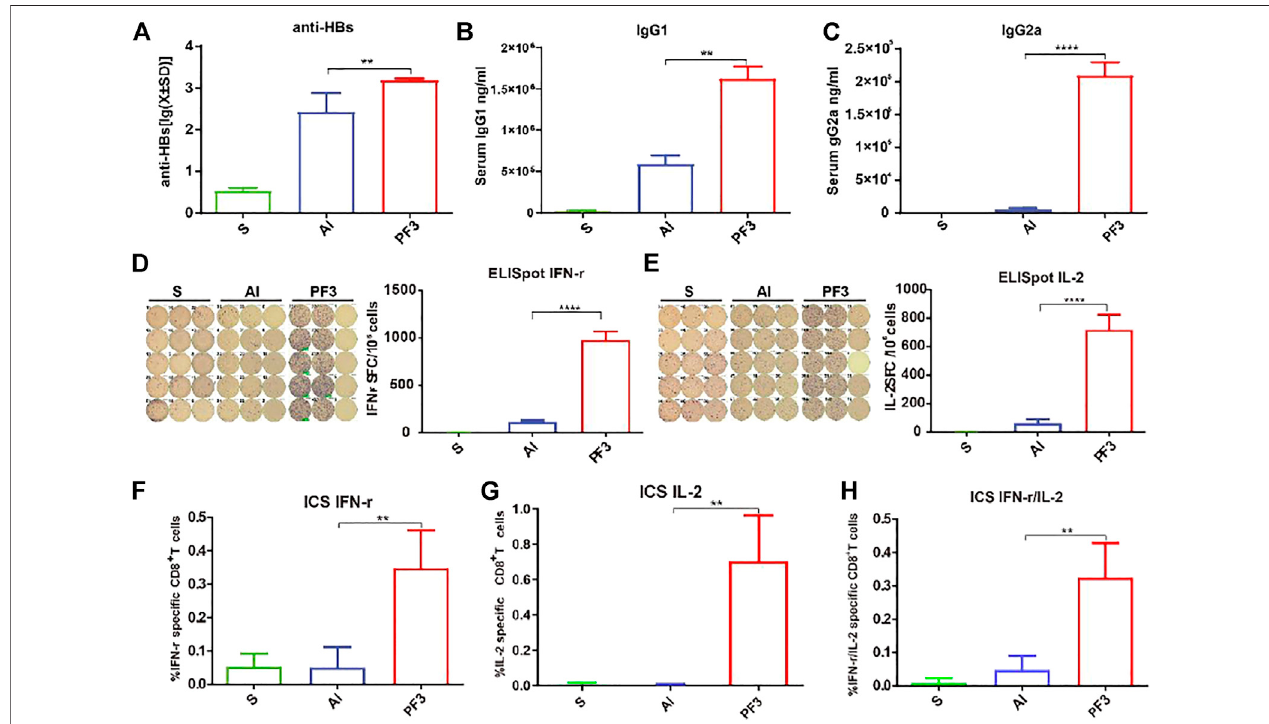
FIGURE 2 | Serum anti-HBs and IgG1 and IgG2a antibody levels of mice and speci fi c T-cell responses measured using ELISpot and ICS immunized with HBsAg combined with different adjuvants. BALB/c mice (n = 5) were immunized intramuscularly with HBsAg (5 μ g/ml) combined with Al (500 μ g/ml), PF3(50 μ g/ml) or Rg1 (50 μ g/ml). (A). anti-HBs (mIU/ml); (B,C). IgG1 and IgG2a (ng/ml); (D,E). ELISpot IFN-r and IL-2; (F – H). ICS IFN-r and IL-2. Data are presented as the means ± SD and are representative of one of two independent experiments with similar results. Note: p p < 0.05, pp p < 0.01, ppp p < 0.001 and pppp p <